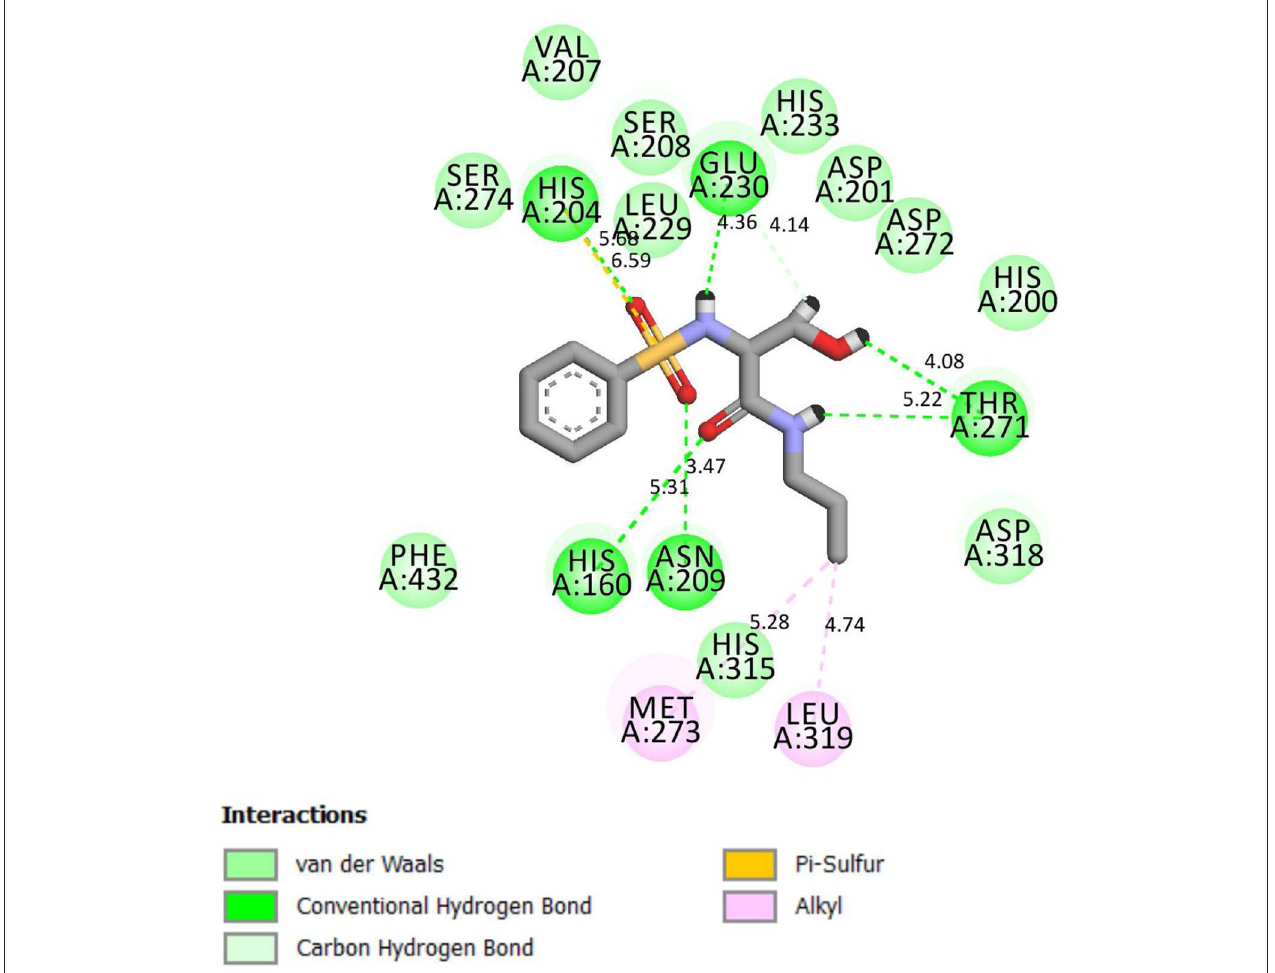
FIGURE 3 | 2D representation of binding interaction of compound 4g and the amino acid residues of 4WCU.